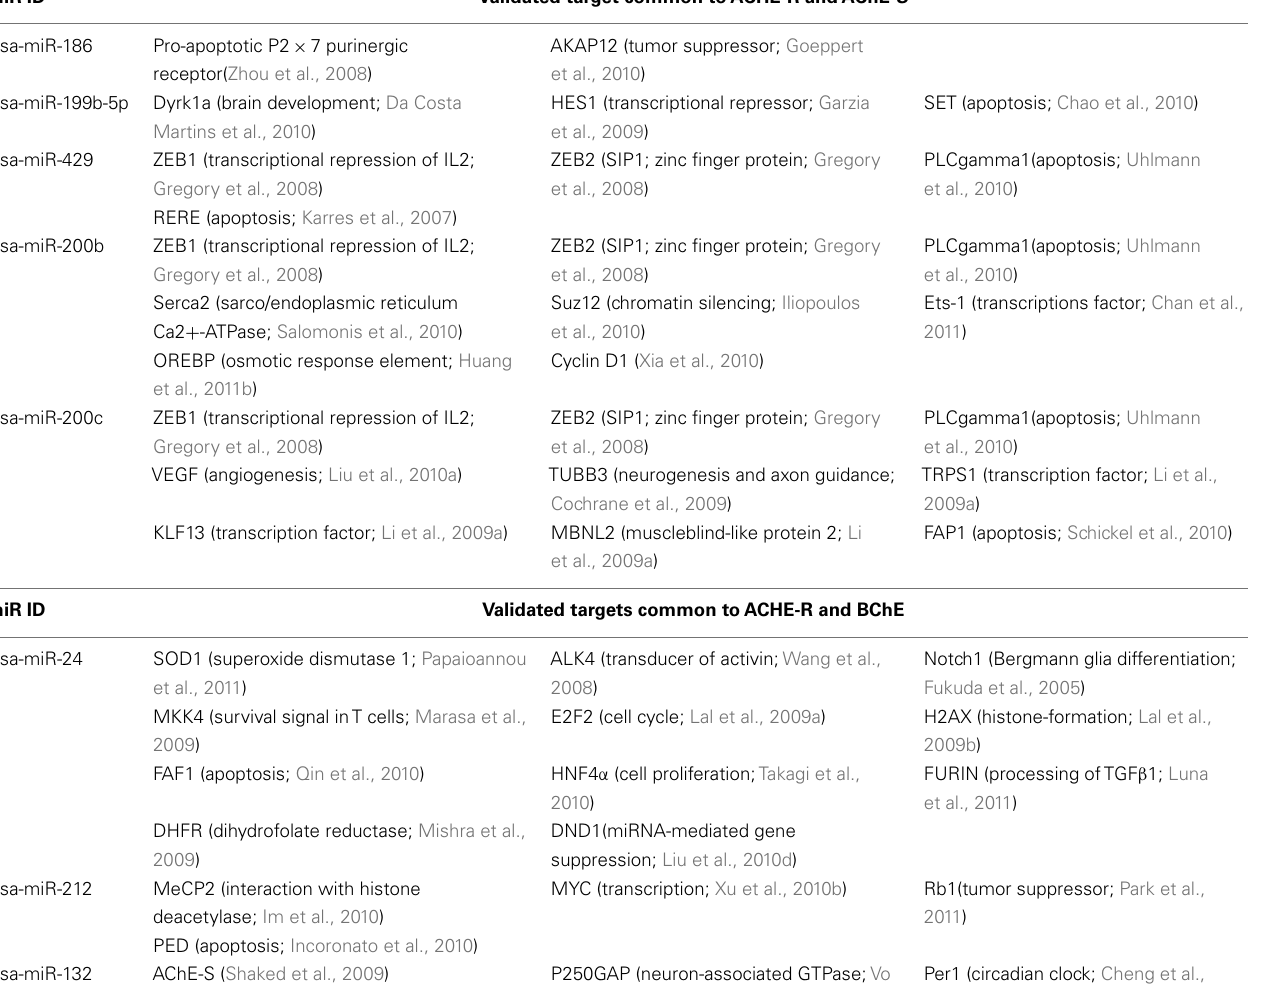
TableA4 |Additional targets of ChE-targeting miRs (common to more than one